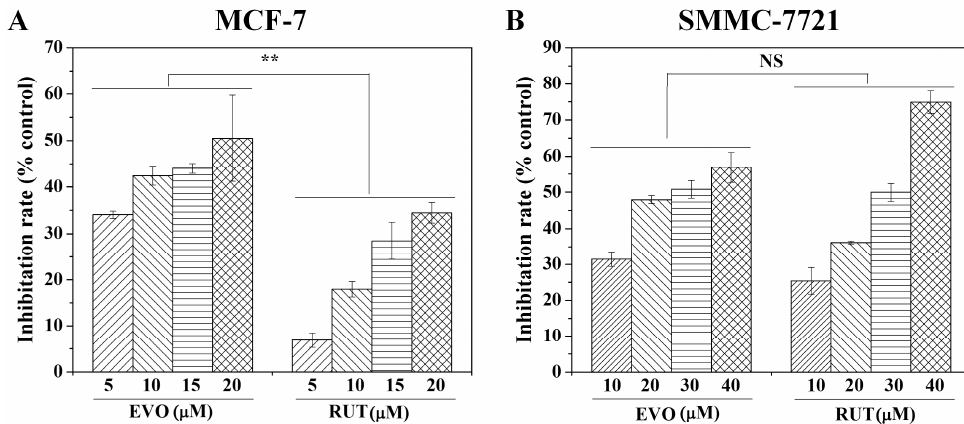
Figure 2. Antiproliferative effects of the model drugs (EVO, RUT) on ( A ) MCF-7 and ( B ) SMMC-7721 cells in 2D model at different drug concentrations after 48 h incubation. The results are expressed as means ± standard deviation (SD) ( n = 3). ** p < 0.01 . NS, no significance. Table 1. The IC 50 values of the model drugs (EVO, RUT) and control drug (CDDP) against the two tumor cell lines in 2D and 3D culture systems at different drug concentrations after 48 h treatment. Unit: μ M. EVO RUT CDDP Cells 2D 3D